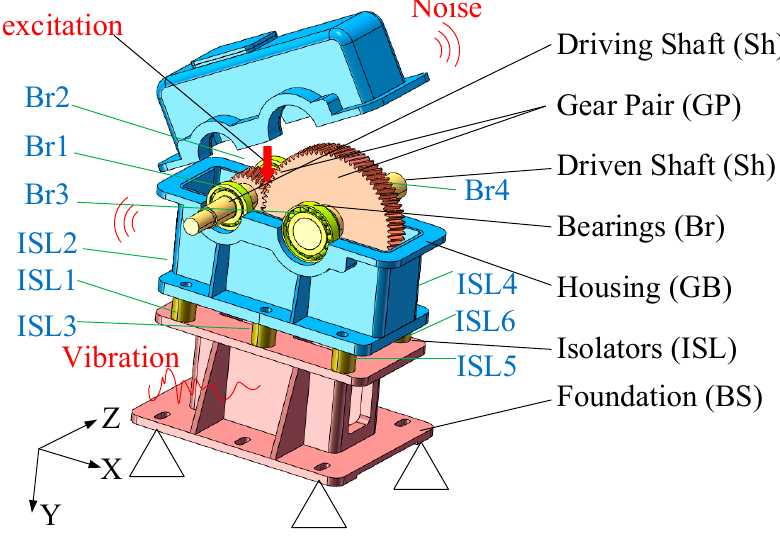
Figure 1. Gear isolation coupled system.